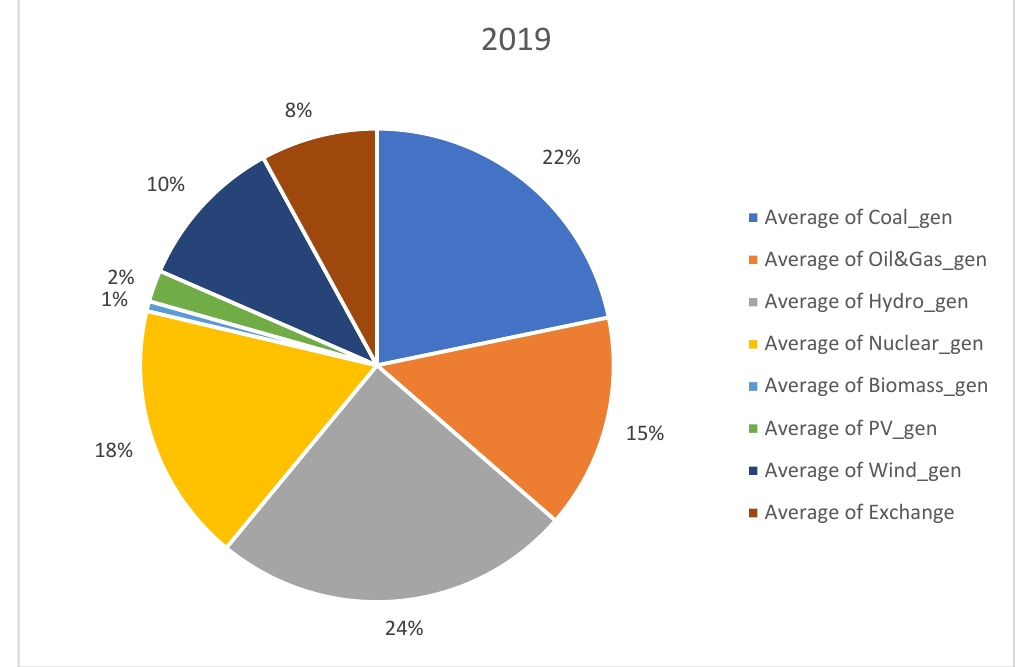
Figure 1. Distribution of generation sources in 2019.